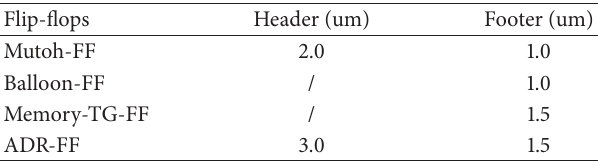
Table 1: The sizes of sleep transistors with different data retention flip-flop